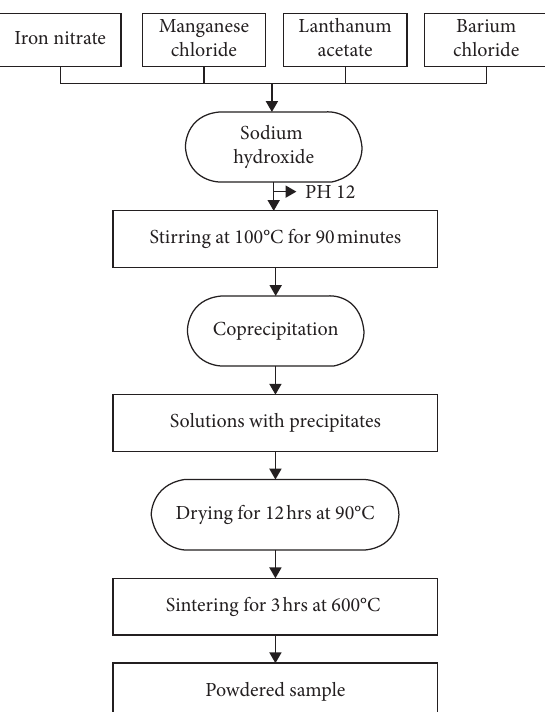
Figure 1: Flowchart of Ba 1 − x La x Mn y Fe 12 − y O 19